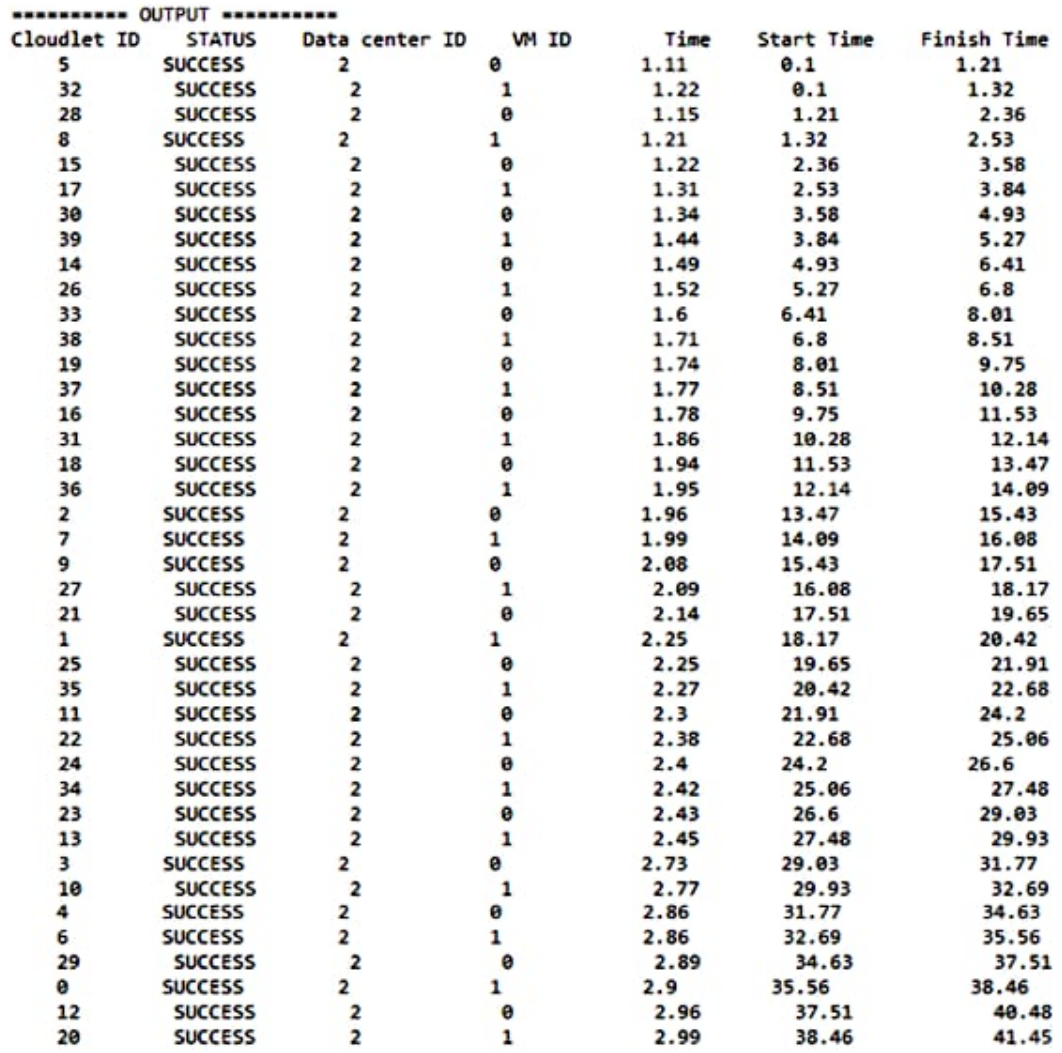
Figure 5. Simulation results of Experiment 1 in terms of computation time for Scenario-1.